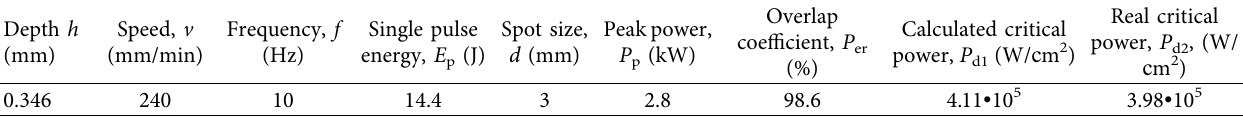
Table 8: Parameters of local laser